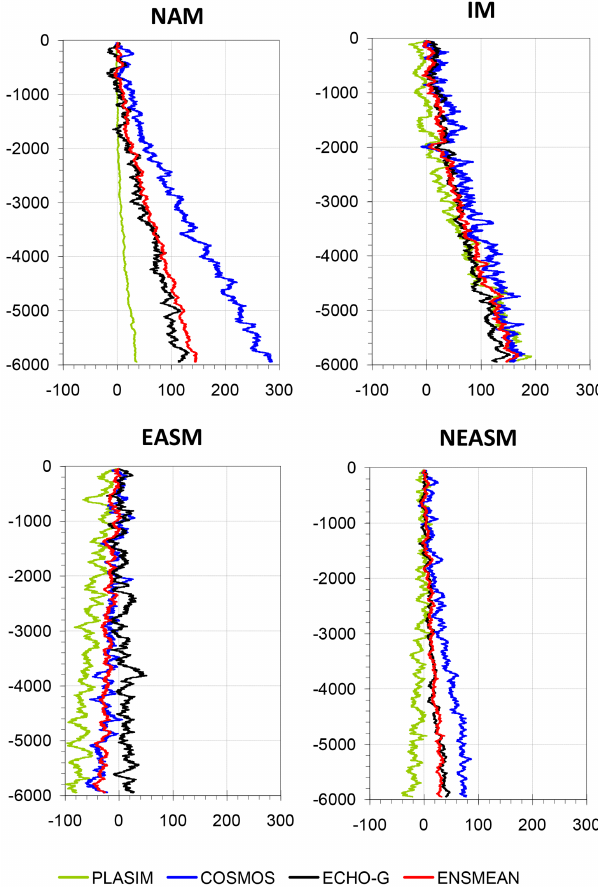
Figure 7. Simulated rainfall trend (100-year running mean, in mmyear − 1 ) in different sub-regions of the Afro-Asian monsoon domain, displayed as an anomaly to the last time-step represent- ing the pre-industrial climate. The regions are: the North African monsoon region (NAM), Indian monsoon region (ISM), East Asian monsoon region (EASM), and the northern part of the East Asian monsoon region